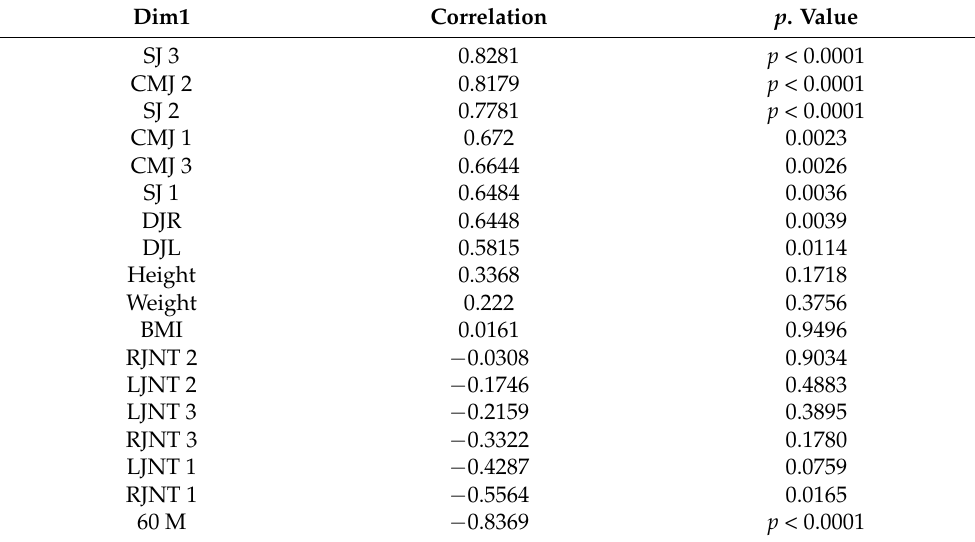
Table 1. Indicators significantly correlated to Dim1.